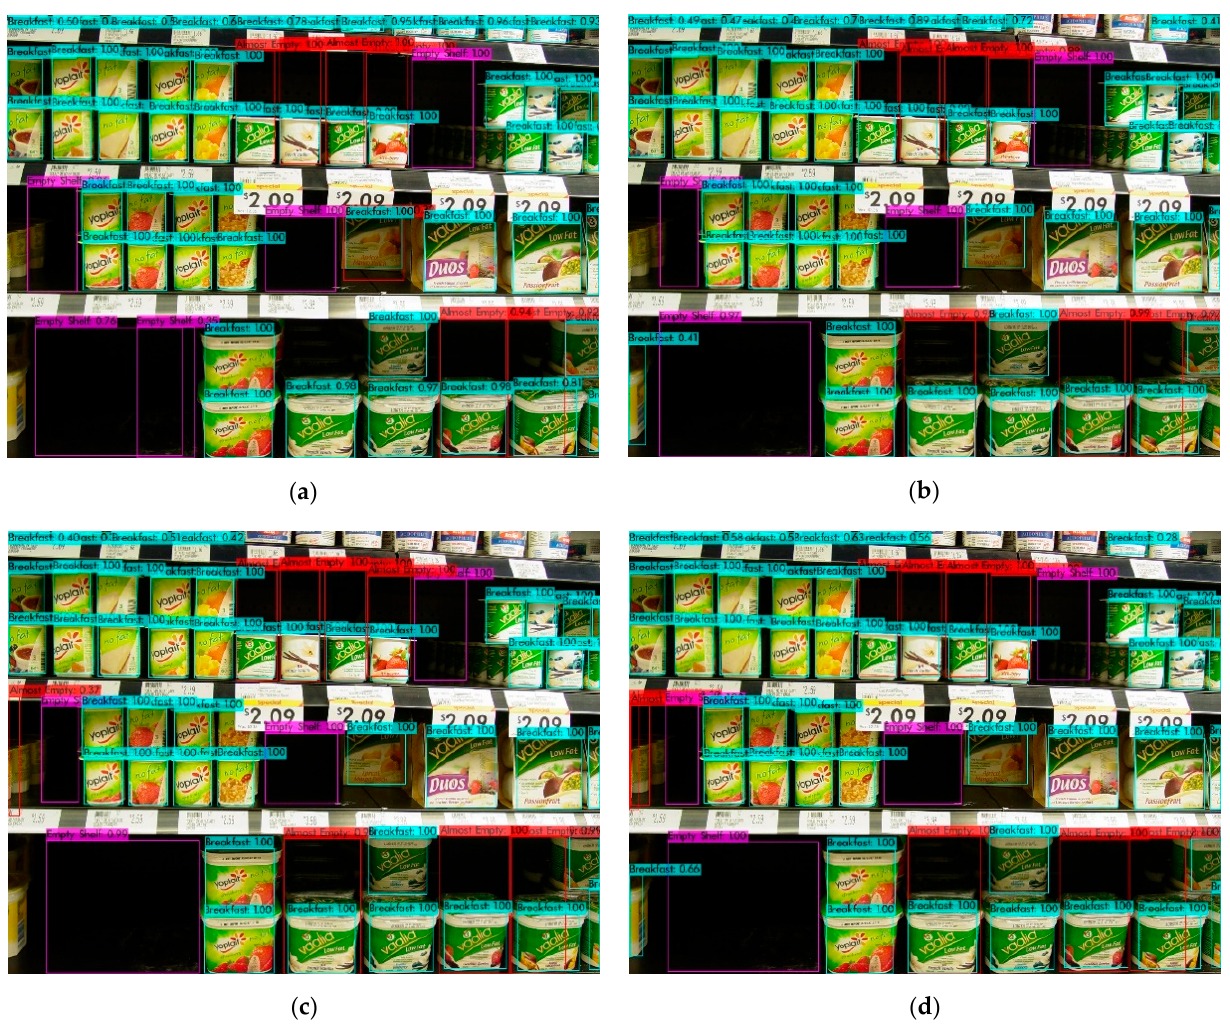
Figure 13. Sample object detection results of the breakfast section. It shows detection results using the model that was trained with ( a ) 20% of labeled images; ( b ) 40% of labeled images; ( c ) 60% of labeled images; and ( d ) 80% of labeled images.